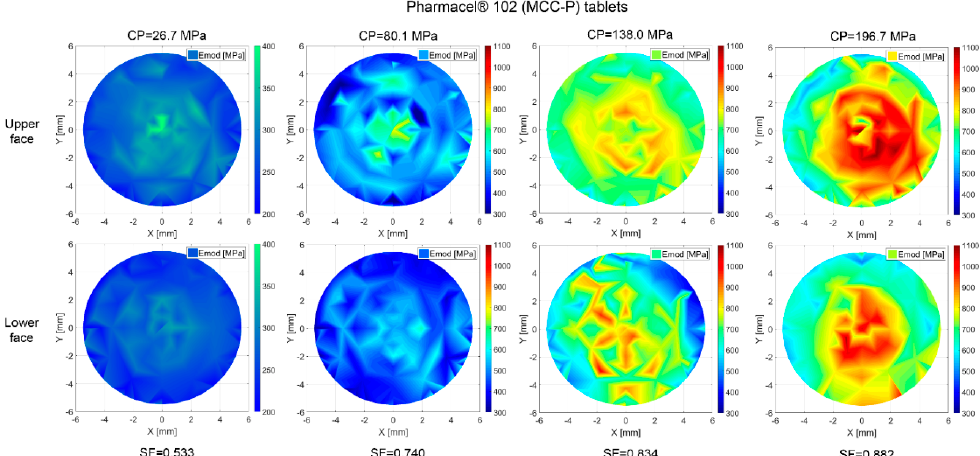
Figure 16. E mod distribution over tablet surface for MCC-P tablets. Coordinates [0, − 5.625] correspond to the frontal part during compaction. The filling shoe approaches from [ − 5.625, 0] with a rotational cycle, and it withdraws following its same path to [5.6250, 0]. Sampling: eight tablets per pressure and face; 79 indents at each tablet face.